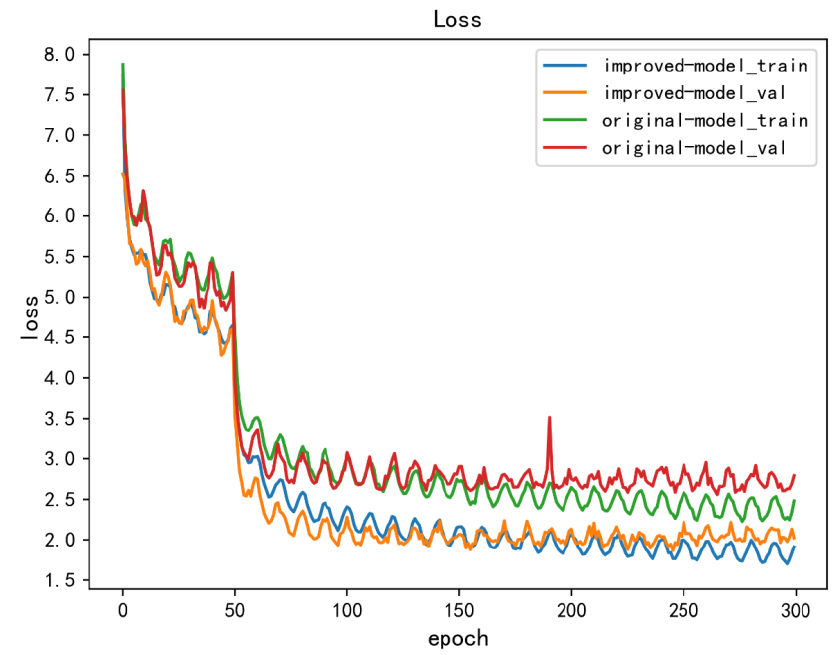
Figure 8. Loss curves of the original model and the improved method.